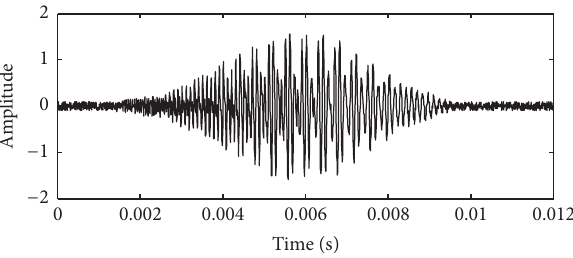
Figure 2: The curve of the sample signal in time